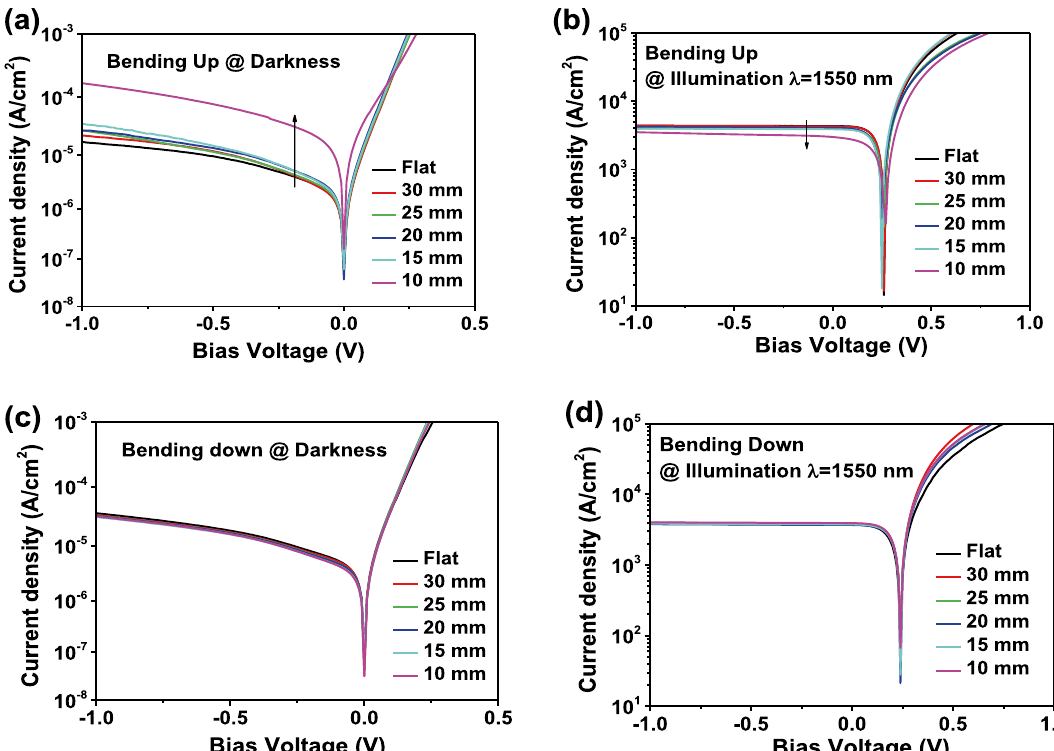
Figure 6. Device characterization under bent conditions: J–V responses of the detector under bending up and down condition. At darkness: ( a , c ) and Illumination: ( b , d ) at 1550 nm (P = 230 the dark current density increases gradually under bent down condition (Fig. 6a) as R reduces. Especially when the R is reduced from 15 to 10 mm, the dark current density increases by 5 times. Meanwhile, the phototcurrent density of the device is stable when the radius reduced from 30 to 15 mm, but decreases by 28% as R is 10 mm. Compared with the bending up condition, the dark current and photocurrent both remain stable under bending down condition, as the radius reduces from 30 to 10 mm. Furthermore, the failure mode of such PDs have been studied deeply. Optical microscope images as shown in Fig. 7 suggest the failure modes of the flexible InGaAs detectors in two bending directions are different. Under bending up condition, cracks are visible at R = 10 mm in Fig. 7a,b, the cracks form perpendicular to the forward direction of dL and propagate from one release hole to another one. The cracks lead to the increase of surface leakage current and the decrease of photocurrent. In addition, once the craking mode occurs, the performance degradation is irreversible. In bending down direction, instead of cracking, we observed that the membrane buckled upward via local delamination from the adhesive at R = 10 mm, as shown in Fig. 7c. The delamination reduces the strain in the membrane thereby preventing the cracking failure mode even at smaller bending radius. Therefore, the device can be bent down to R = 10 mm while keeping the integrity and stable photo response of the device. As the bending radius decreases further, the delamination continues to expand, as shown in Fig. 7d. Even if the bending is released, the membranes do not slip back and stay in delamination forever. Instead of the fracture strains of membranes suffering, the interfacial shear stresses are responsible for the failure behavior and the delamination failure is sensitive to the adhesion strength of film to the substrate 48 . Hence, increasing the adhesion strength of InGaAs membrane PD to PET helps to overcome delamination. According to the study about the failure mode of bending silicon ribbons on plastic substrates, the thickness of the silicon ribbons determines the dominant failure mode of the bending mechanics. As the thickness increases, the dominant failure mode is as follows: cracking, slipping and delamination 48,64,65 . However, there are two failure modes for the InGaAs flexible PD with a fixed thickness in two bending direction. Unlike the silicon ribbon, the InGaAs flexible PD is a composite multilayer asymmetric structure, the effect of bending strain on each layer of material is different. As shown in Fig. 1b, SU-8 layer, Si 3 N 4 layer and the metal contact coated on the InGaAs PIN membrane structure, asymmetrically from top to bottom. The failure mode is supposed to occur from one layer and transmit to the whole structure. Top and bottom thin metal contact has ductility, and its contribution to the failure membranes can be neglected. The comparison of the Young’s moudlus for SU-8, Si 3 N 4 and InGaAs PIN membrane is: SU-8 (3–5 GPa) < InGaAs PIN membrane (60–80 GPa) < Si 3 N 4 (220–230 GPa). The failure mode is more likely to occur in InGaAs PIN membrane and Si 3 N 4 . Considering the thickness of the three materials, it can be assumed that, cracking failure dominated in bending up caused by thin Si 3 N 4 , and the delamination failure dominated in bending down caused by thick InGaAs PIN expitaxy layer. The quantitative analysis of this hypothesis can be further studied, and provide guidance for the bending performance optimization.